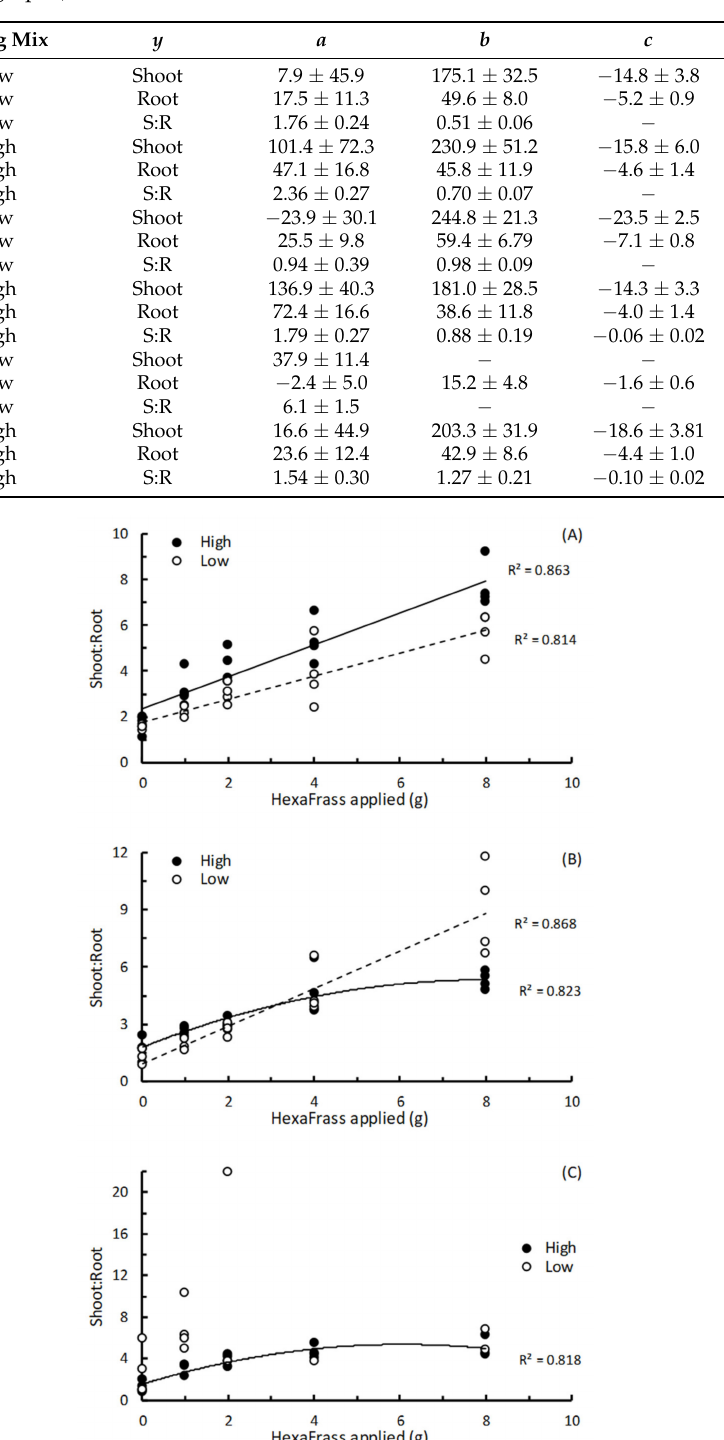
Table 3. Estimates of parameters ( ± SE) for polynomial and linear regression for shoot and root dry wt (mg) and shoot:root (S:R) dry wt ratio for basil, lettuce and parsley plants treated with different quantities of HexaFrass™ (HF). Polynomial regressions were of the form y = a + b (HF) + c (HF 2 ). Linear equations were of the form y = a + b (HF). HF Max is the point estimate of HF calculated as − b /2 c when the maximum value (Max) of each response variable would be obtained (see Figures 1 and 2 for graphs).